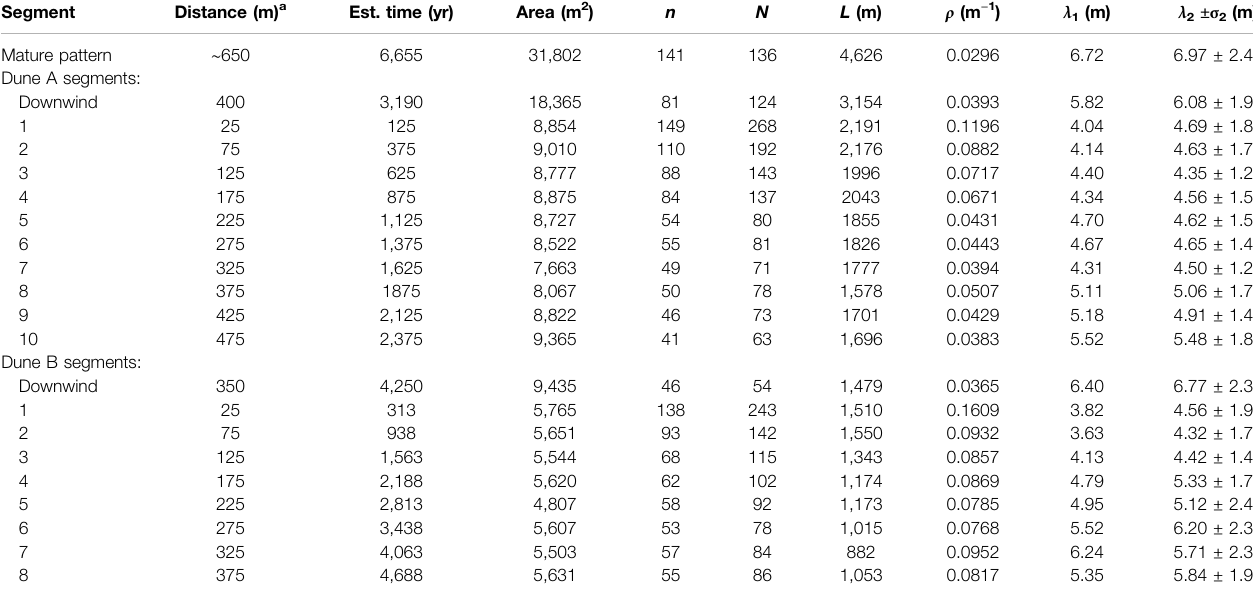
TABLE 3 | Pattern analysis measurements of